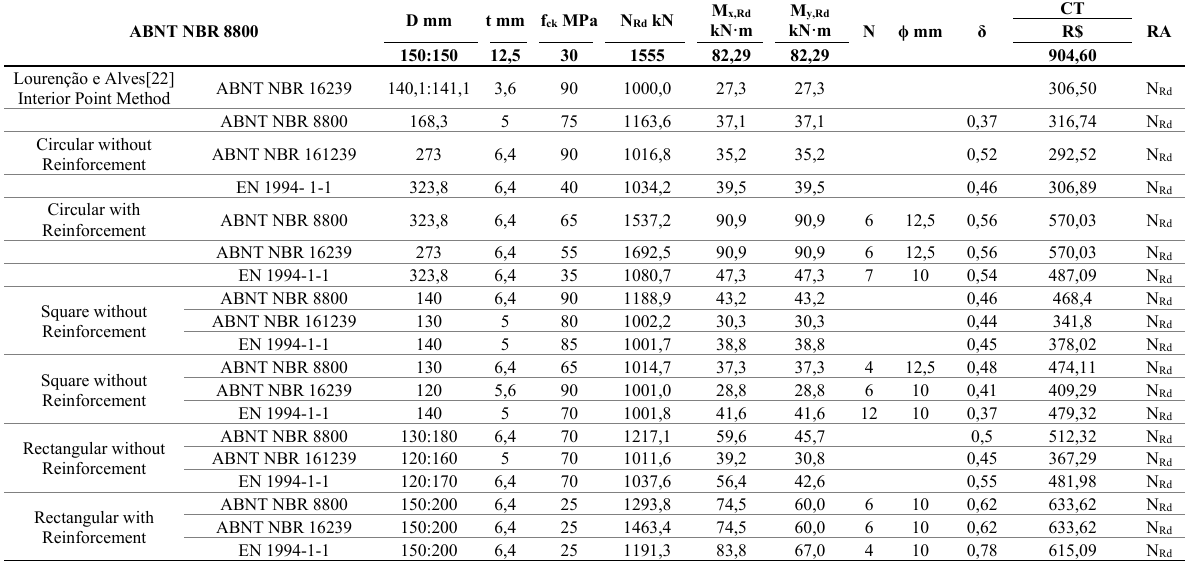
Table 4 – Optimization Results Example 1: L=3m; N Sd =1000kN ABNT NBR